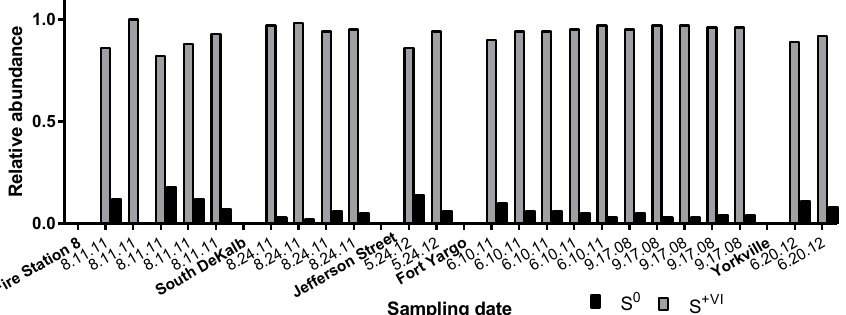
Figure 3. Oxidation state of individual aerosol particles. The oxidation state of sulfur was examined in individual particles from a subset of samples. The fractional relative abundance of S 0 (black) and S + VI (grey) is shown for each particle interrogated with S-NEXFS. At the individual particle level, sulfur is consistently seen at both the S 0 and S + VI oxidation